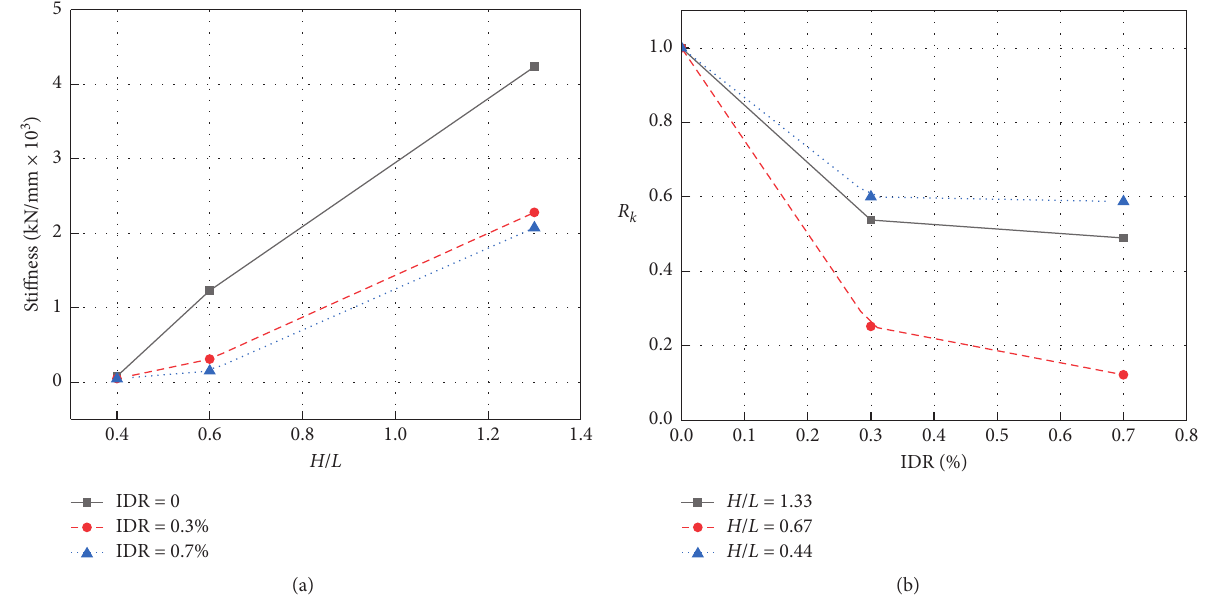
Figure 11: The effect of (a) aspect ratio and (b) IP damage on the OOP stiffness of the infill